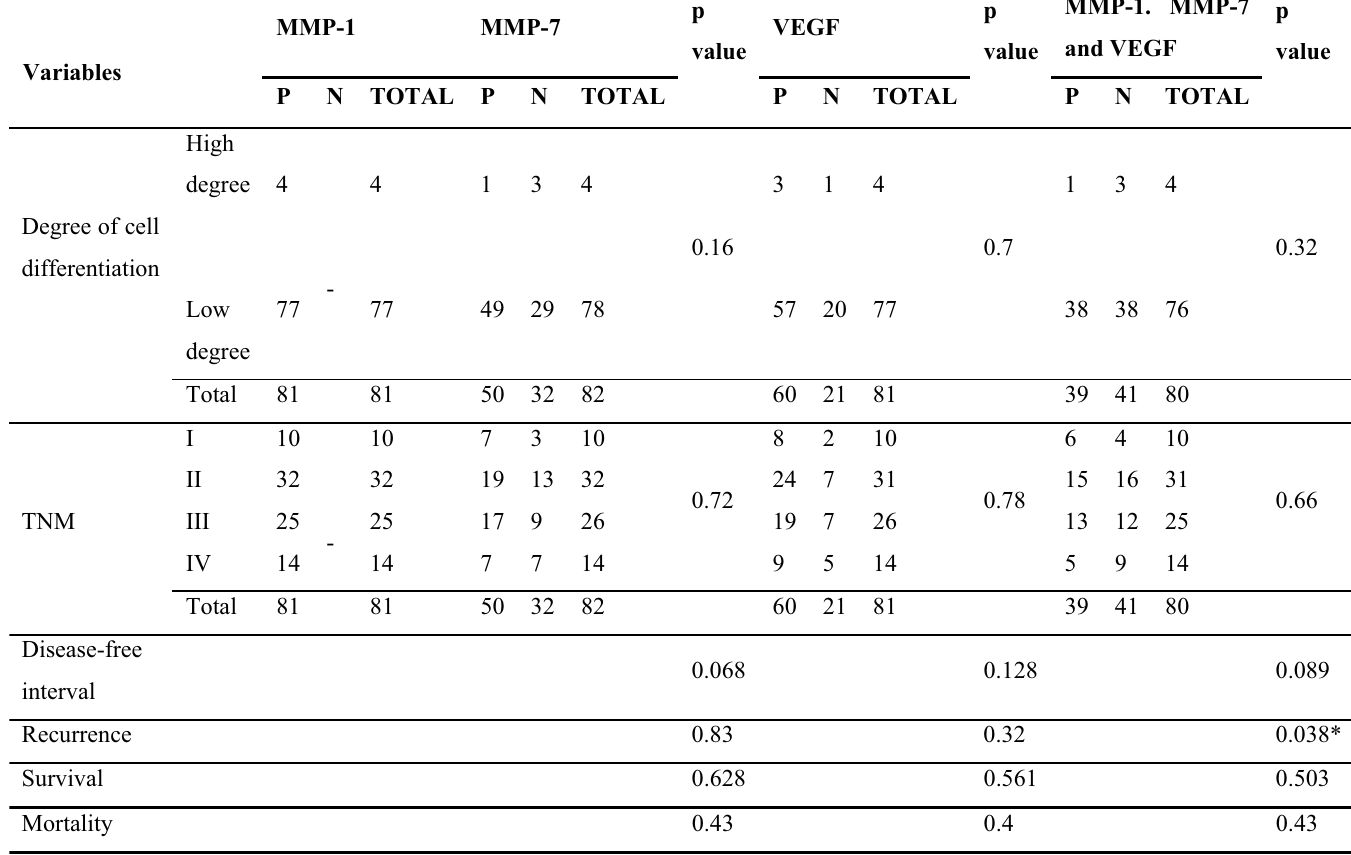
TABLE 3 – Distribution of results for tumor expression of MMP-1, MMP-7 and VEGF in relation to the clinical and pathological variables